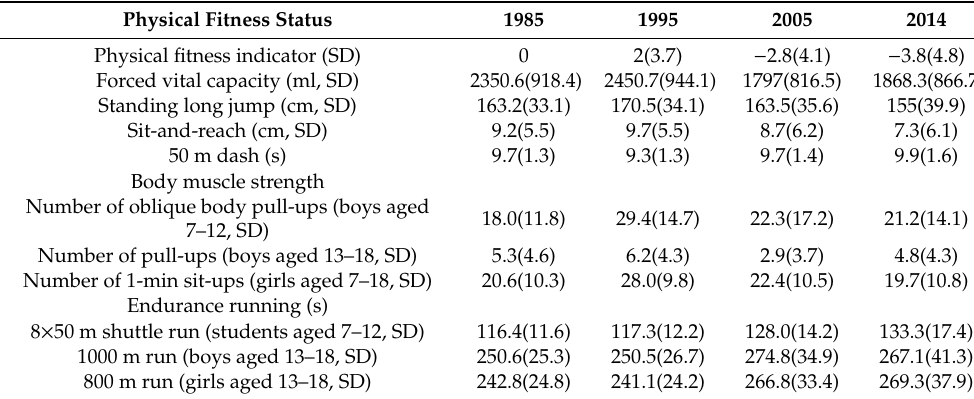
Table 2. Six core items of physical fitness among children and adolescents aged 7–18 in Xinjiang, from 1985 to